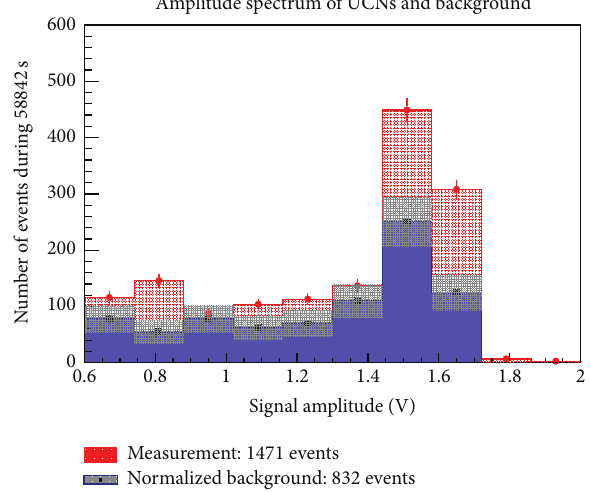
Figure 19: Amplitude spectrum of UCNs and background. The temperature of the source was 1.35